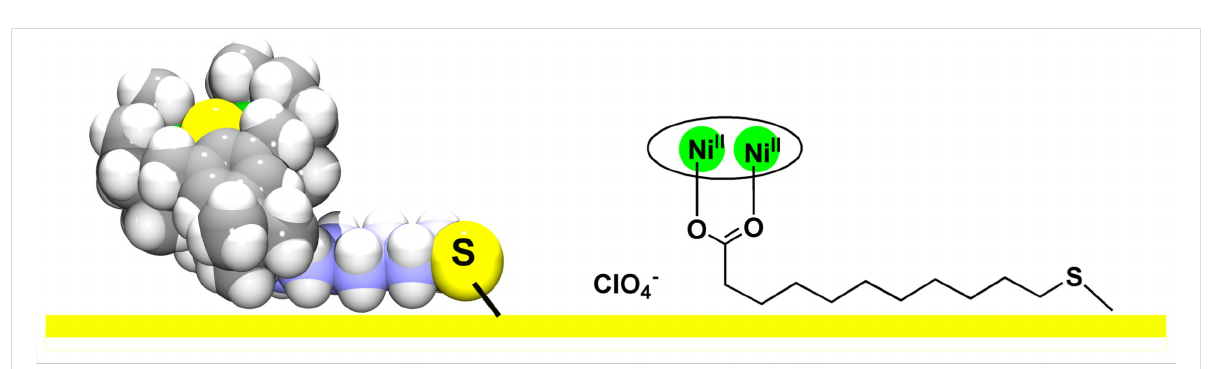
Figure 6: Proposed binding mode of complex 7 to gold (left: van der Waals representation of the [Ni 2 L(L 5 )] + cation; right: representation with a Lewis formula. The macrocycle is shown as an ellipse encircling the two Ni 2+ ions for